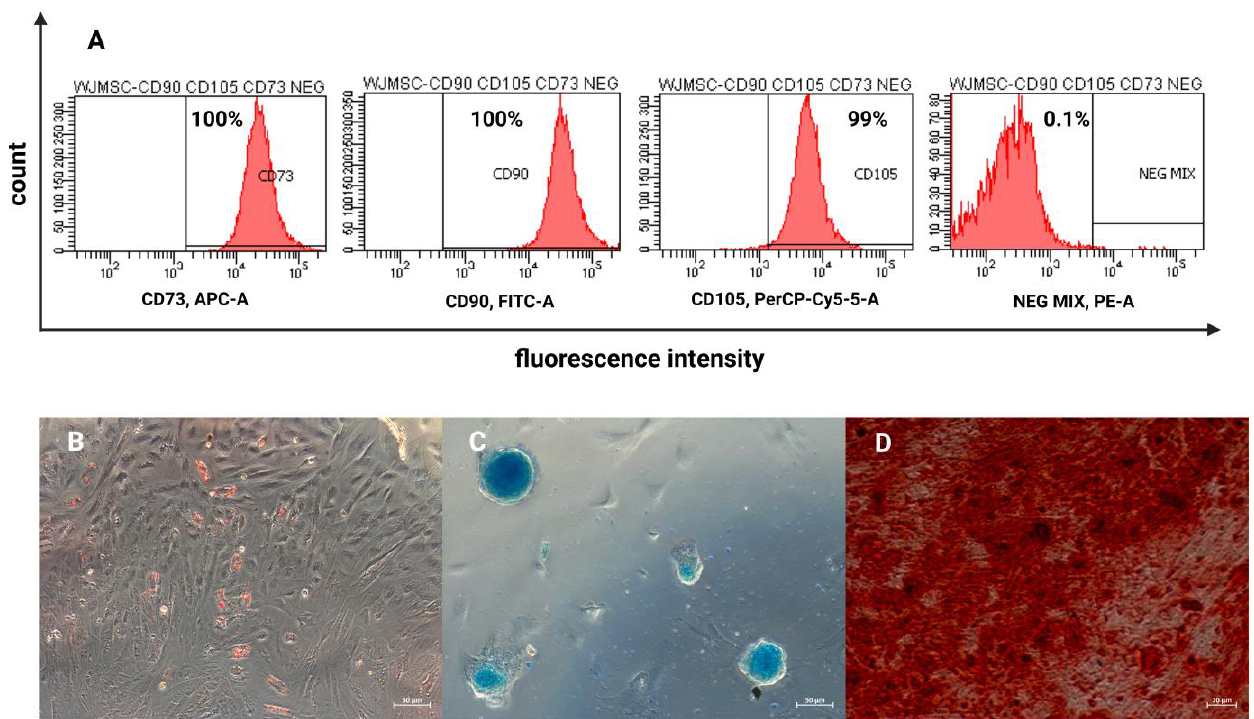
Figure 2. ( A ) Flow cytometry analysis. The number of cells expressing CD determines the peak in the lower-right quadrant. The latter analysis showed culture with a relatively clear expression of specific mesenchymal markers (CD73, CD90, and CD105) — more than 99% positive markers. Not more than 1% of the WJ-MSCs expressed negative markers (CD34, CD11b, CD19, CD45, and HLA-DR); ( B ) adipogenesis — positive Oil Red O staining (red fat drops), scale bar: 50 µm; ( C ) chondrogenesis — positive Alcian blue staining for the presence of cartilage glycosaminoglycans, scale bar: 50 µm; ( D ) osteogenesis — positive Alizarin Red staining, scale bar: 50 µm.